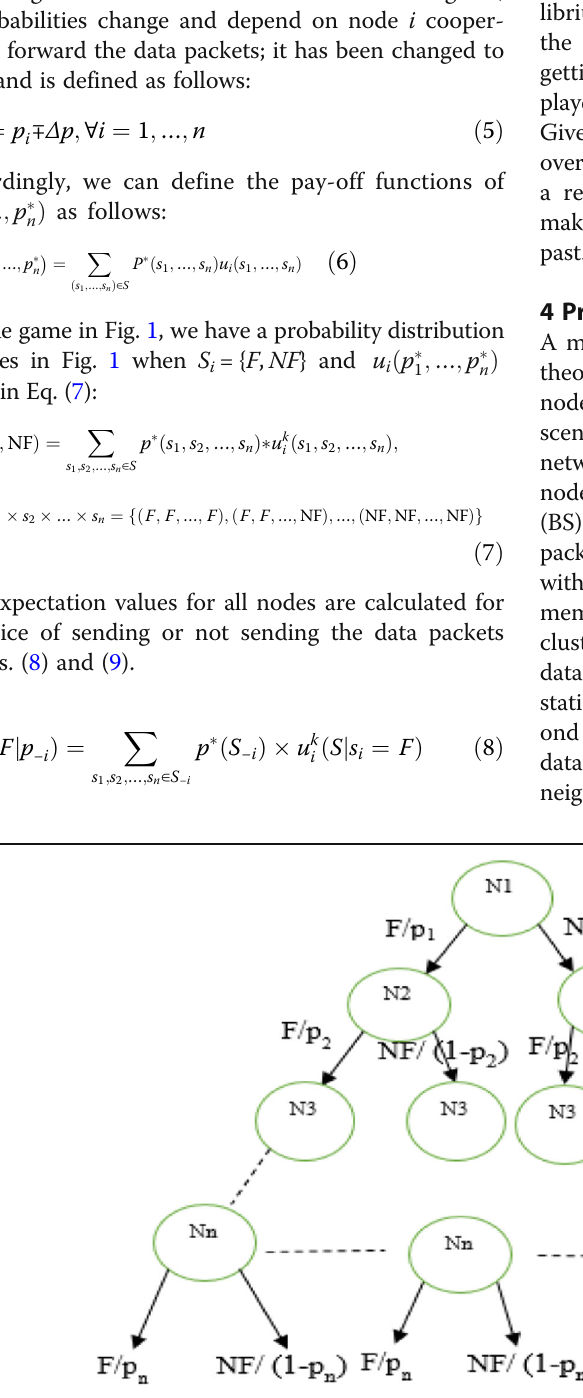
Fig. 1 Chart of forwarding or not forwarding the data